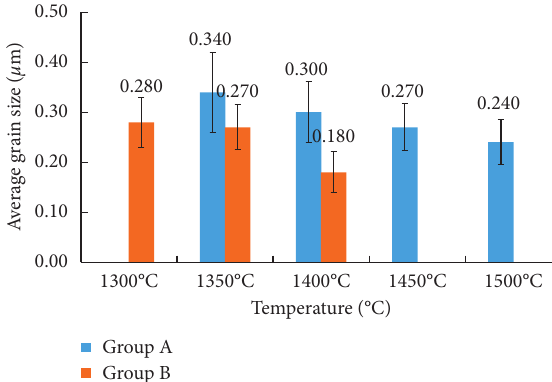
Figure 11: Average grain size of two samples in groups A and B at different sintering temperatures.